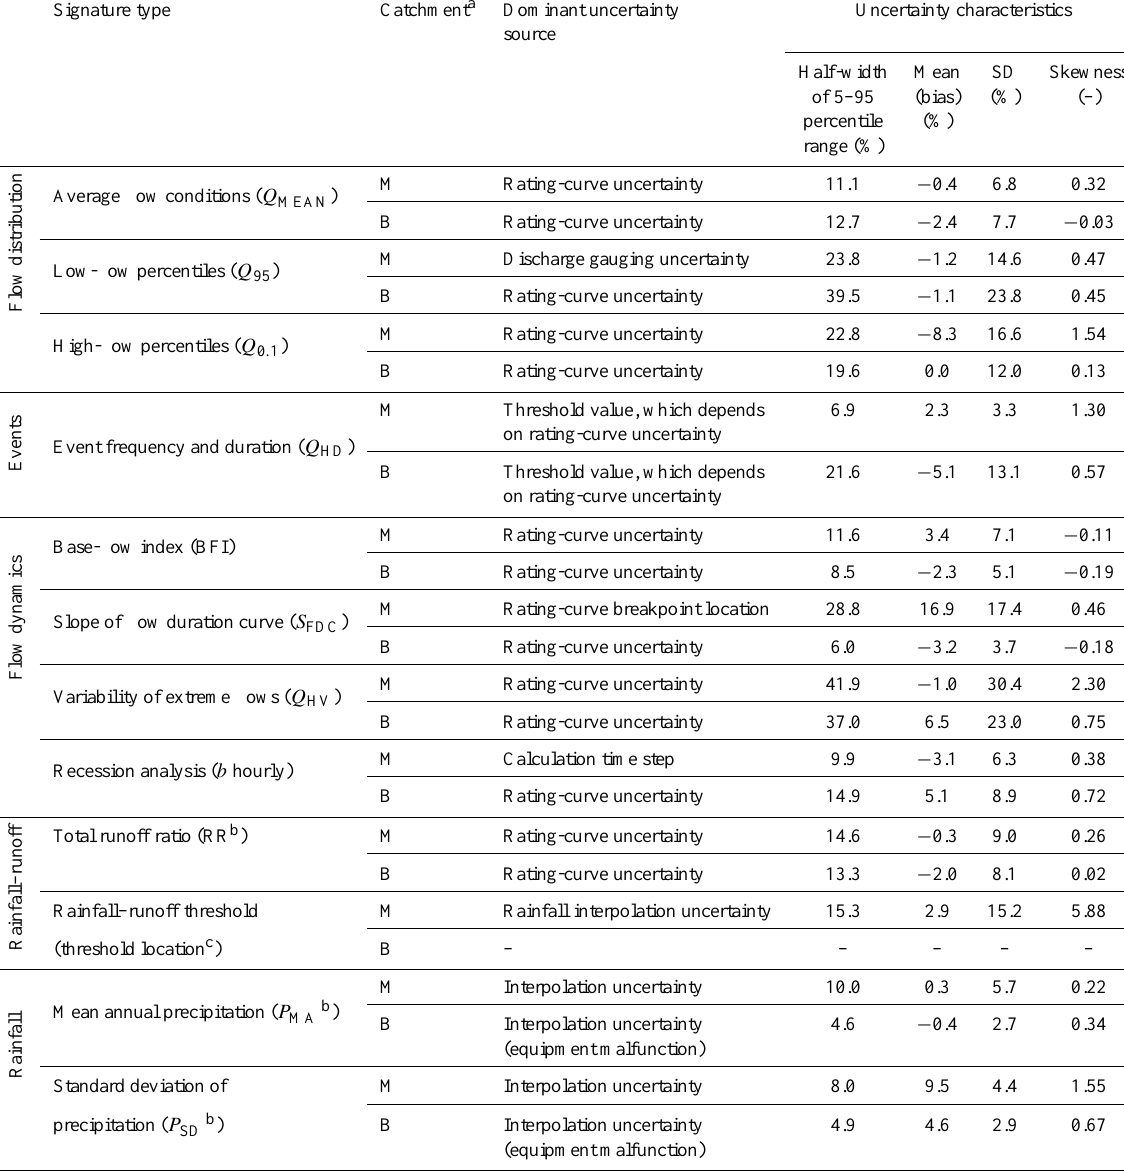
Table 3. Dominant uncertainty sources and uncertainty